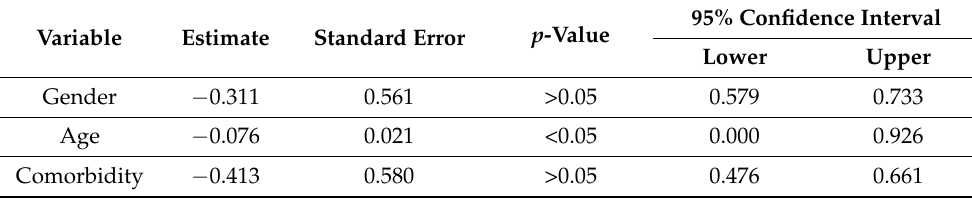
Table 4. Prediction of disease outcome based on sociodemographic variables. Variable